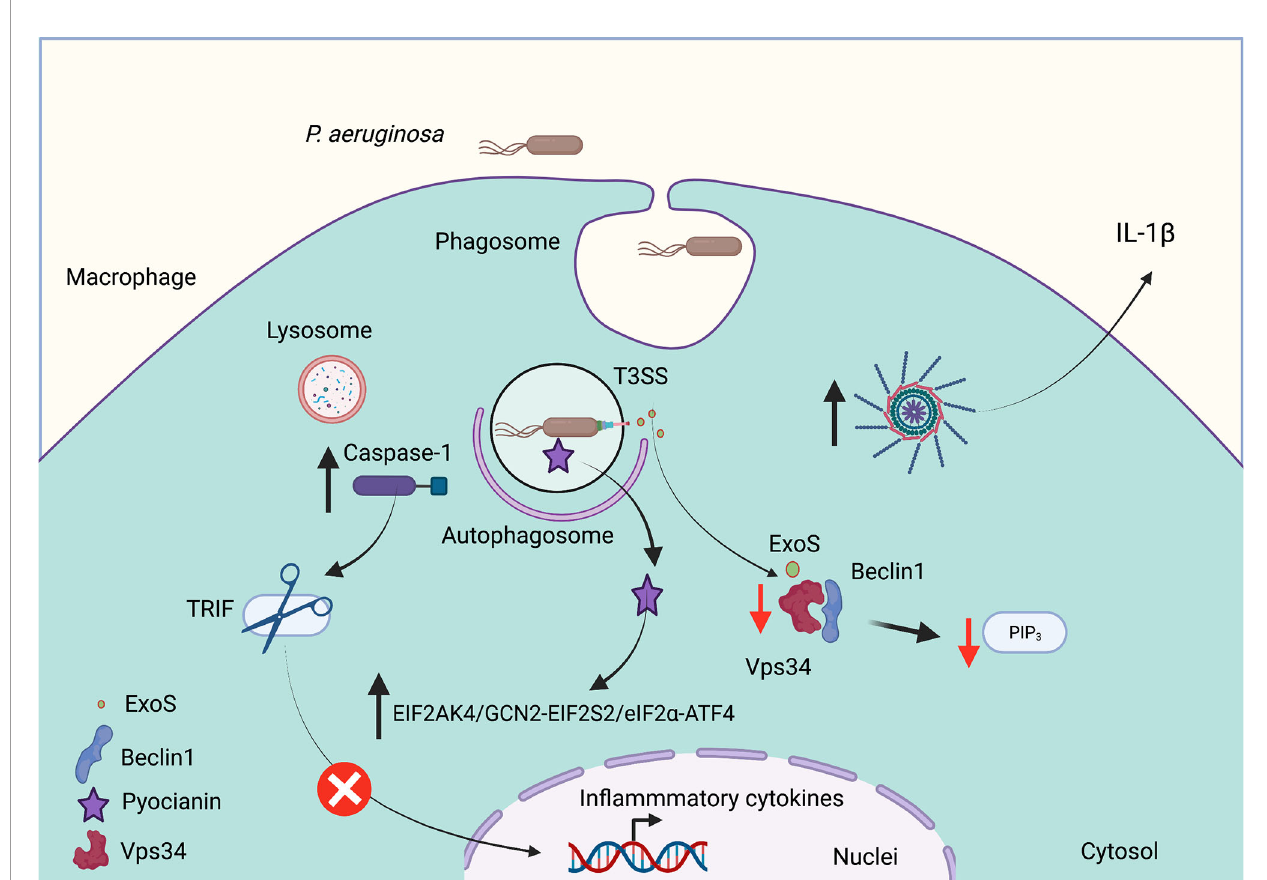
FIGURE 2 | Pseudomonas aeruginosa subverts autophagy in cystic fi brosis. P. aeruginosa invades phagocytic and epithelial cells, which modulates the autophagic pathway to survive. Cell infection induces NLRP3 in fl ammasome activation to release IL-1b. Caspase-1 activation also mediates TRIF degradation to decrease the in fl ammatory response. The Type III Secretion System (T3SS) releases ExoS, a toxin with ADP ribosylation activity that decreases the Vsp34 activation to produce phosphatidylinositol (3,4,5) trisphosphate (PIP 3 ). The release of pyocyanin promotes autophagy through the EIF2AK4/GCN2 (eukaryotic translation initiation factor 2 a kinase 4) – EIF2S2/eIF2 a (eukaryotic translation initiation factor 2 subunit a ) – ATF4 (activating transcription factor 4) pathway. Red arrows indicate decreased autophagy, and black arrows indicate increased autophagy. Created with